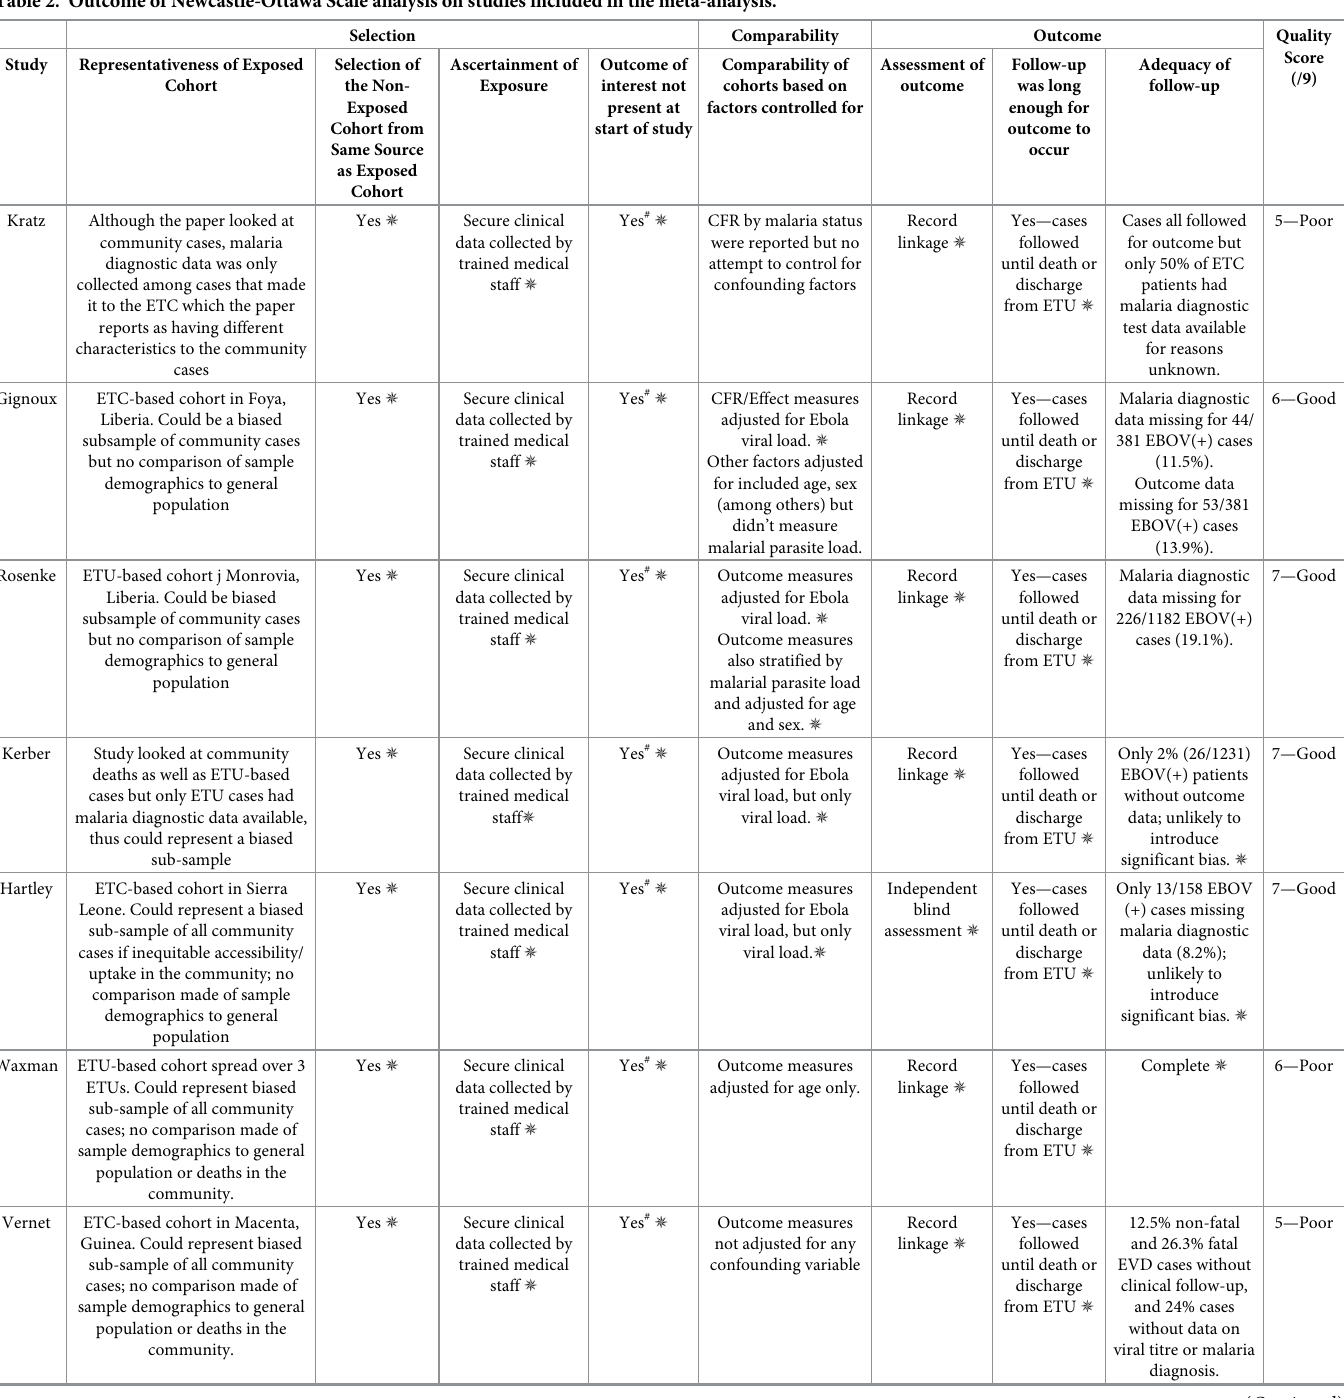
Table 2. Outcome of Newcastle-Ottawa Scale analysis on studies included in the